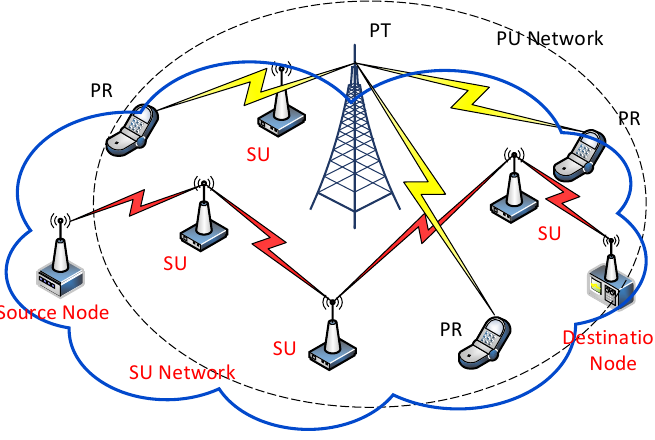
Figure 2. Cognitive radio ad hoc networking scenarios (PT: primary user transmitter, PR: primary user receiver).